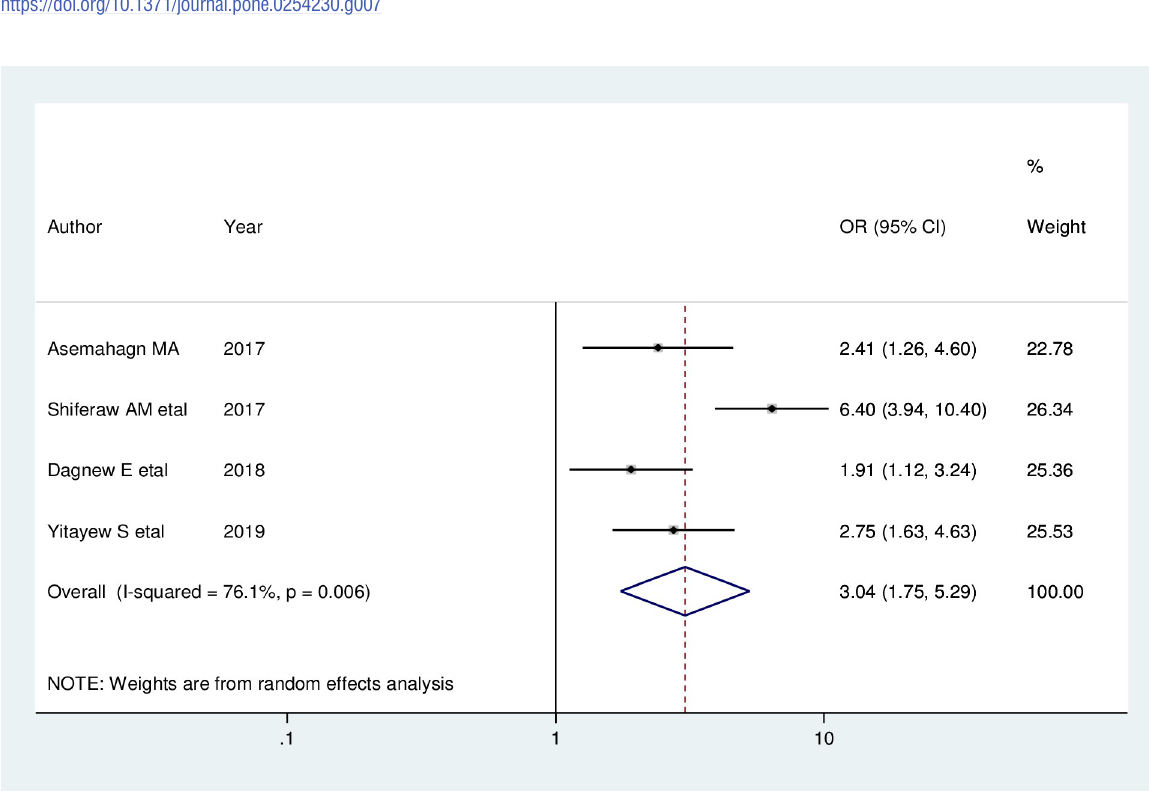
Fig 8. Forest plot showing the pooled odds ratio of the association between data management knowledge and utilization of routine health information health workers in Ethiopia, 2020.